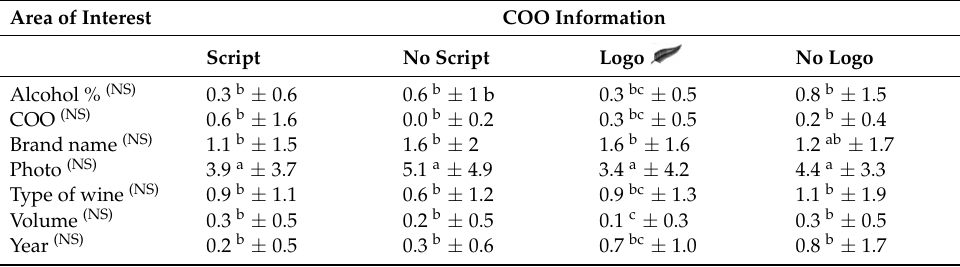
Table 4. Means and standard deviations of the fixation count on each AOI for four labels *.